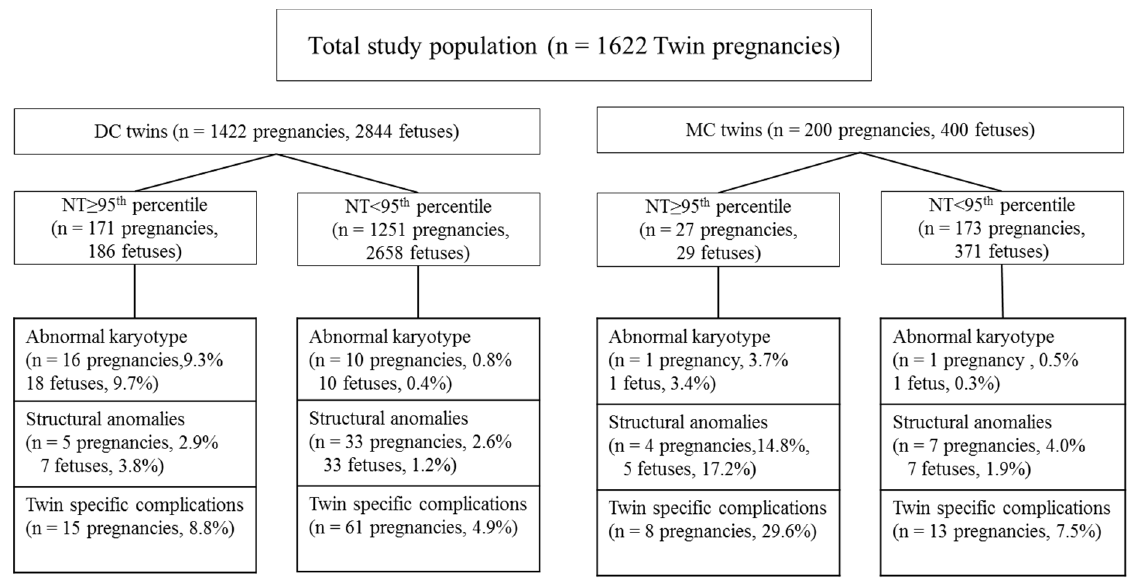
Figure 1. Flow chart summarizing the clinical outcomes of the study population ( n = 1622). DC, dichorionic; MC, monochorionic; NT, nuchal translucency